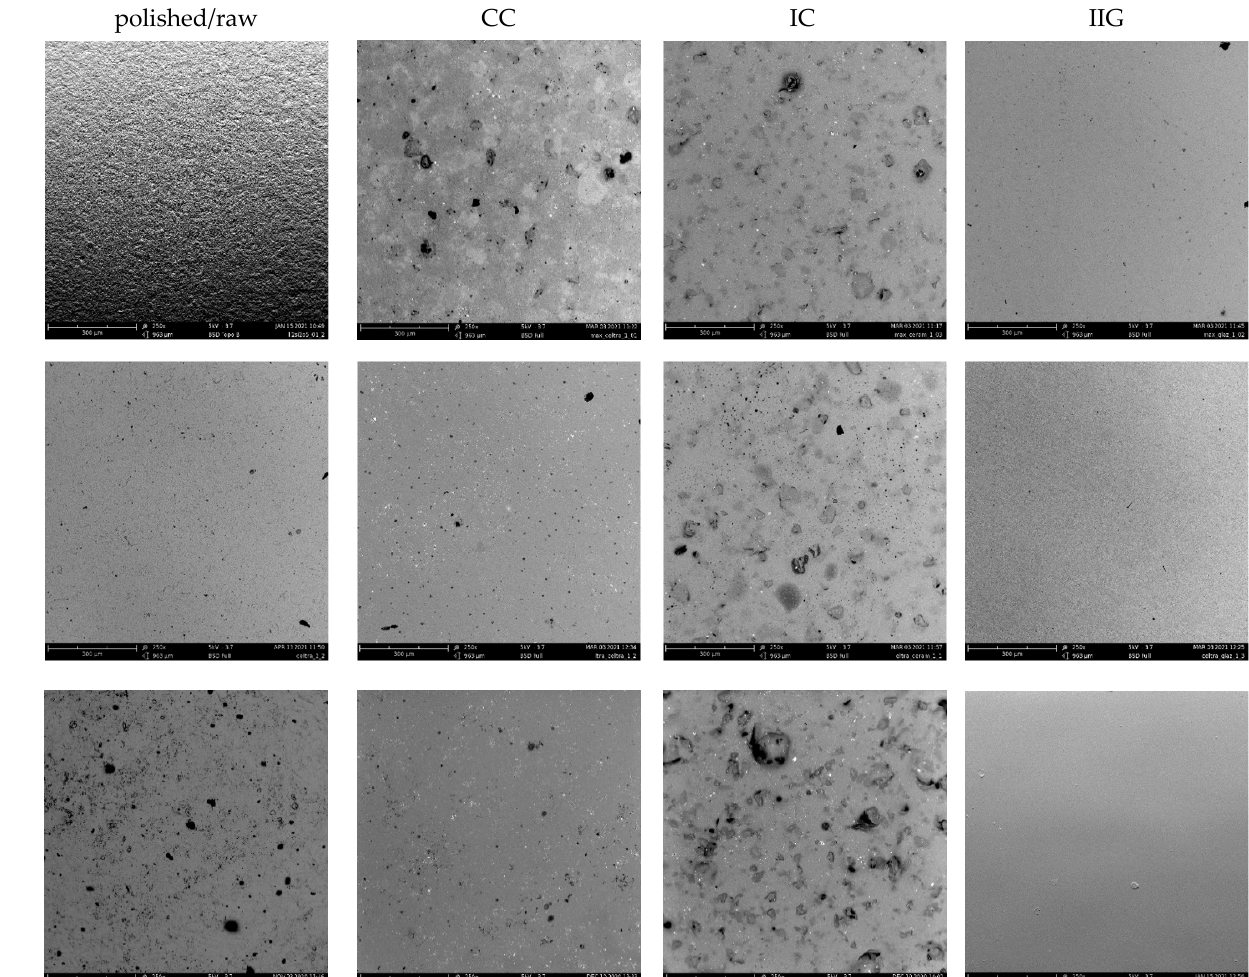
Figure 4. The surface area difference (SAD) data for 20 μ m × 20 μ m area of the tested ceramic surfaces before and after glazing.